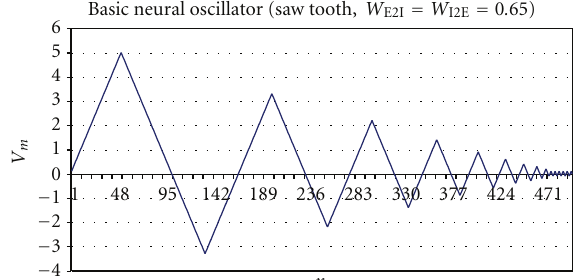
Figure 3: Output of a neural oscillator created by adding a constant ( C = . 1) in the Exciter state and subtracting a constant ( C = . 1) in the Inhibitor state with weights W E2I and W I2E less than